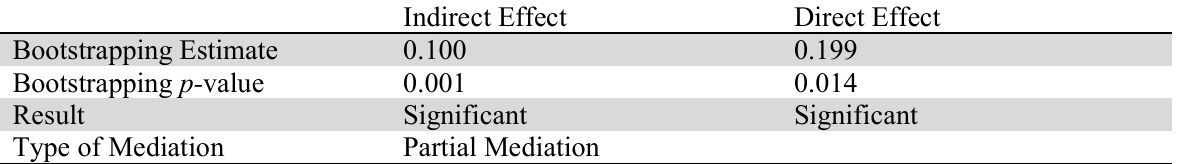
The Results of Direct and Indirect Effects (Subjective Norm = SN, Personal Values = PV, and Intention to Use =